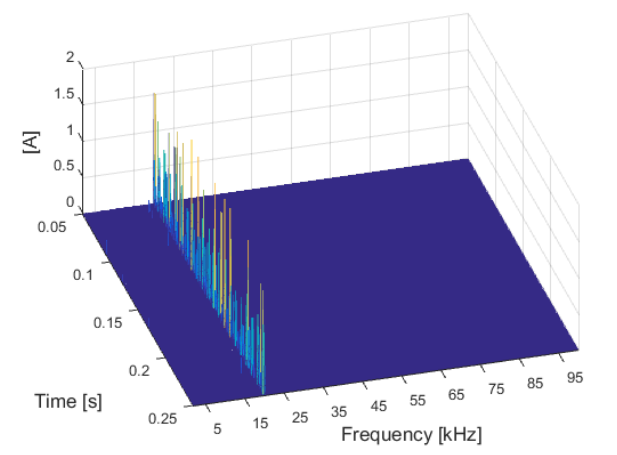
Figure 3. Case study 1: 3D representation of the high-frequency spectra obtained by means of the